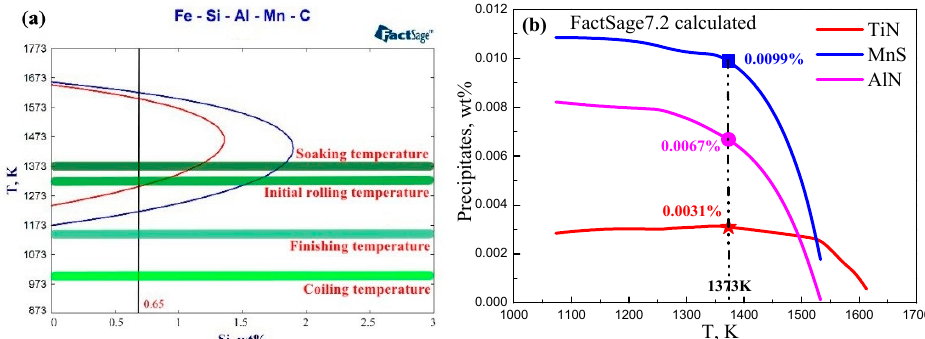
Figure 6. Fe-Si-0.3 wt%Al-0.25 wt%Mn phase diagram ( a ) and precipitation curve of precipitates ( b ).